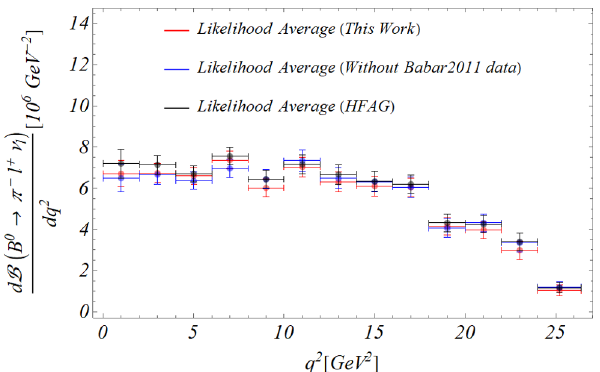
Figure 1 . The comparison of our average q 2 spectrum of the partial branching fractions in B → π‘ν with the one obtained by